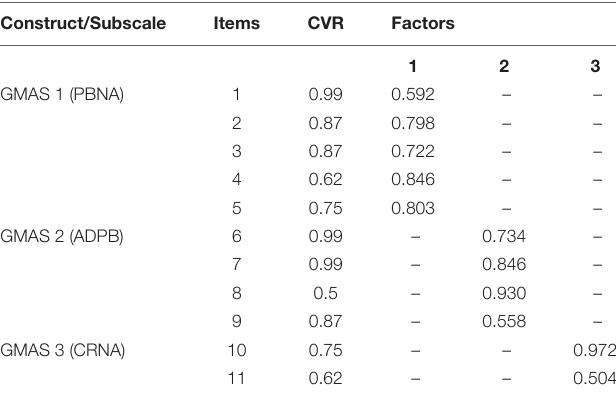
TABLE 1 | Content validity ratio (CVR) and factor